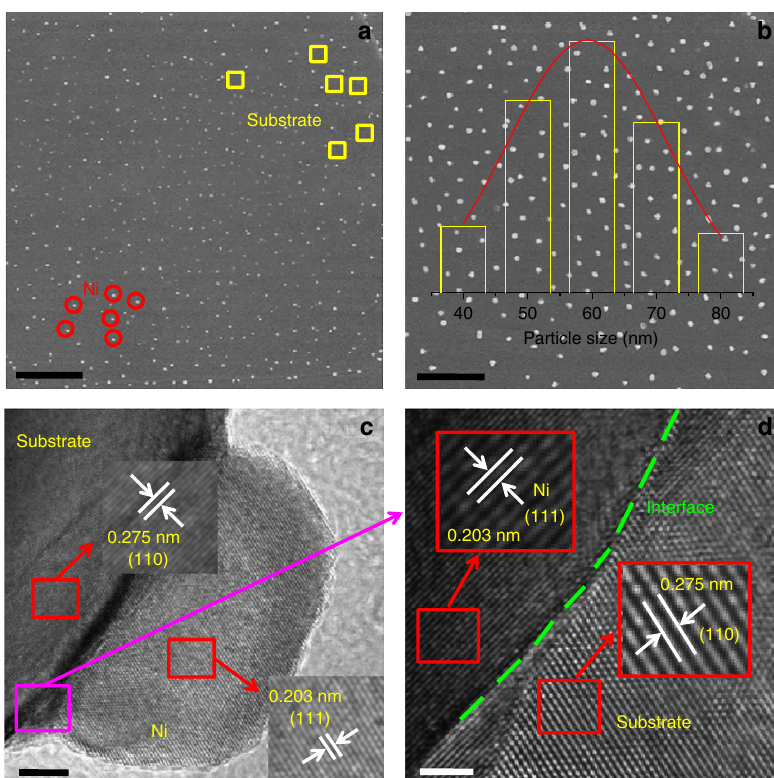
Figure 2 | Scanning electron microscopy and high-resolution transmission electron microscopy for LSTMN A (cid:2) sample. ( a ) Scanning electron microscopic results for the reduced LSTMN A (cid:2) , Scale bars, 5 m m; ( b ) Ni nanoparticles size distribution of the reduced LSTMN A (cid:2) inset, Scale bars, 3 m m; ( c ) High-resolution transmission electron microscopic results for the reduced LSTMN A (cid:2) , Scale bars, 5nm; ( d ) the legible hetero-junction of Ni and substrate along the corresponding to pink square shown in ( c ), Scale bars,